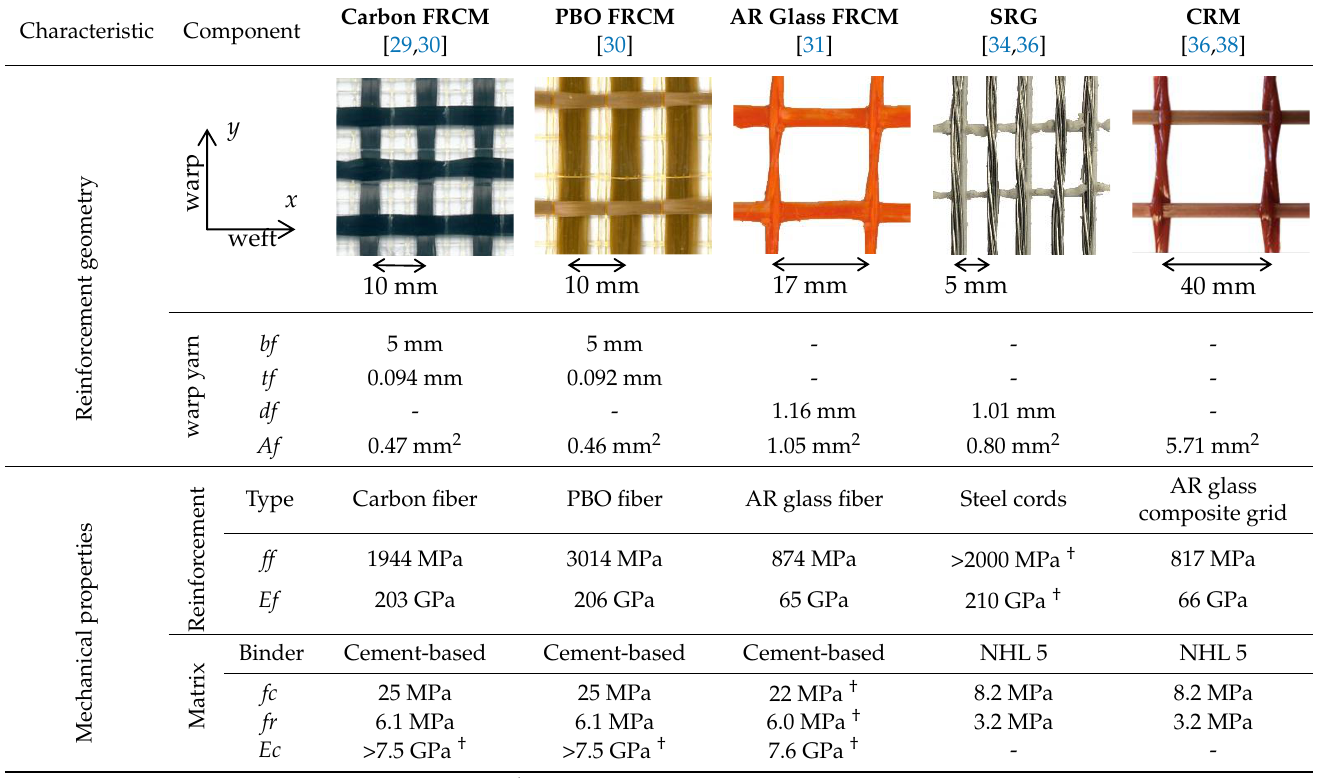
Table 1. Inorganic-matrix reinforcements geometrical and mechanical properties. Characteristic Component